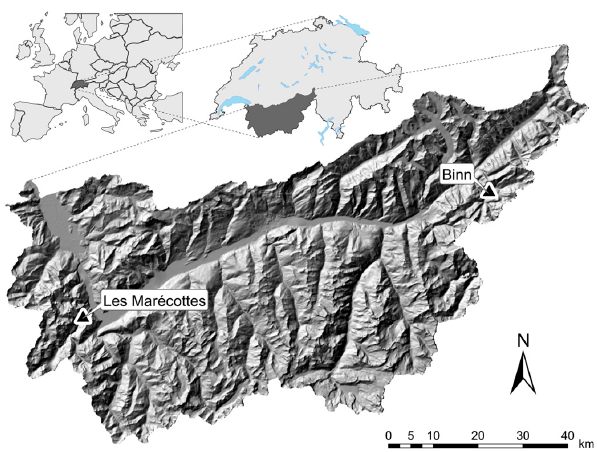
Fig. 1. Location of the alpine Rhˆone catchment in Switzerland and the two rain gauge stations of interest (source: